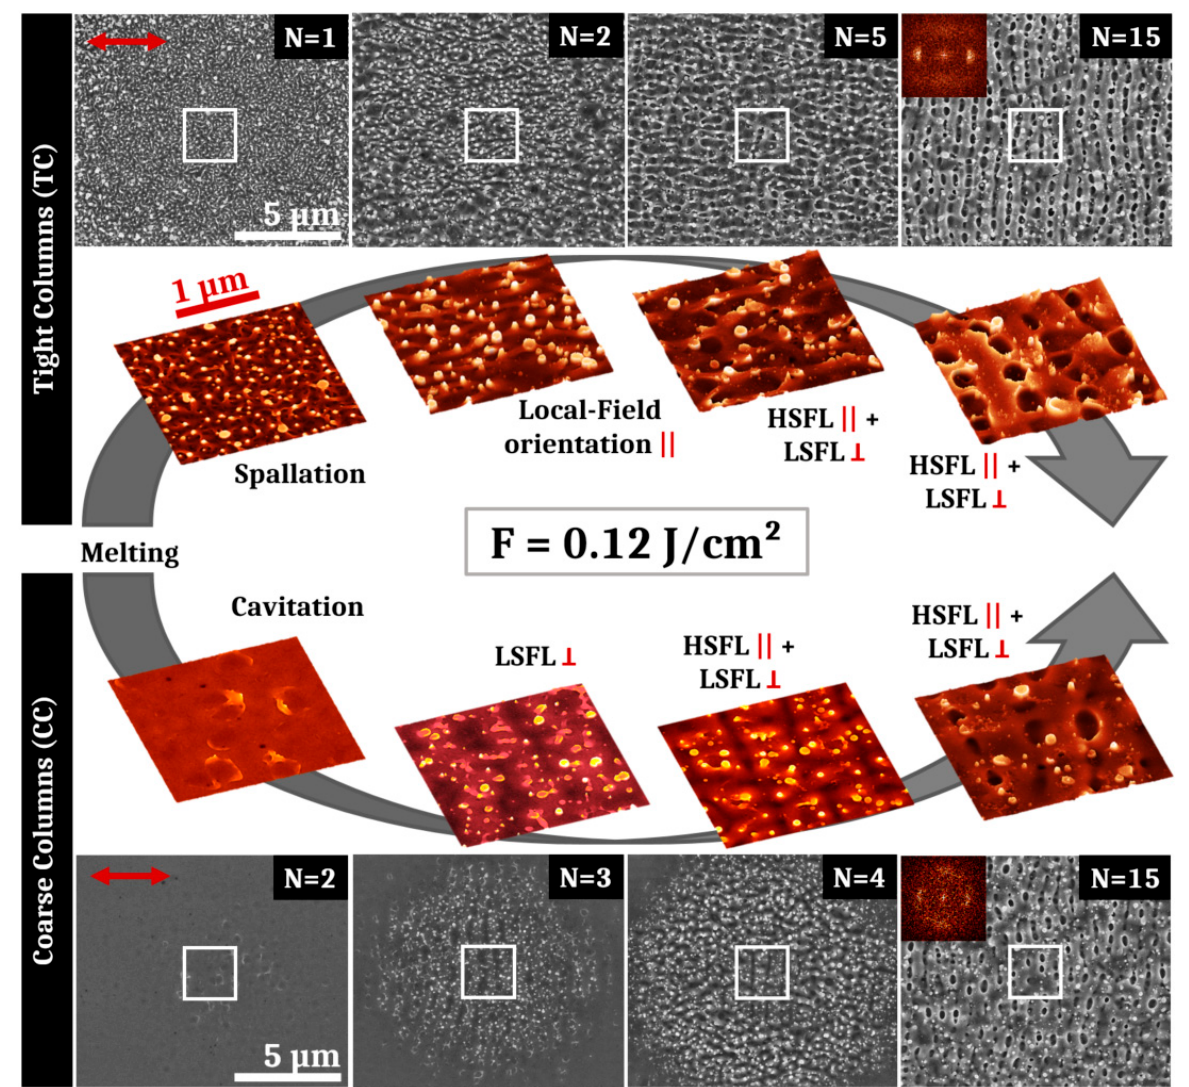
Figure 3. SEM and 3D-projections of SEM pictures of surface structures obtained after irradiation of the Tight Columns and the Coarse Columns samples with an average fluence of 0.12 J/cm 2 and different numbers of pulses. The evolution of structures is shown for different numbers of pulses. For the TC sample, successively appear disorganized filaments induced by spallation (N = 1), orientated filaments (N = 2), high spatial frequency laser-induced periodic surface structures (HSFL) parallel to the polarization intertwined between low spatial frequency laser-induced periodic surface structures (LSFL) perpendicular to the polarization (N = 5 and N =15). For the CC sample, successively appear residual cavitation bubbles (N = 2), LSFL (N = 3), horizontal HSFL and vertical LSFL (N = 4 and N = 15). The red arrow represents the electric field polarization. The symbols (||) and ( ꓕ ) respectively mean “parallel” and “perpendicular” to the polarization. 2D-Fourier transforms shown as insets support the presence of a crossed structure of HSFL and LSFL for the highest pulse numbers.